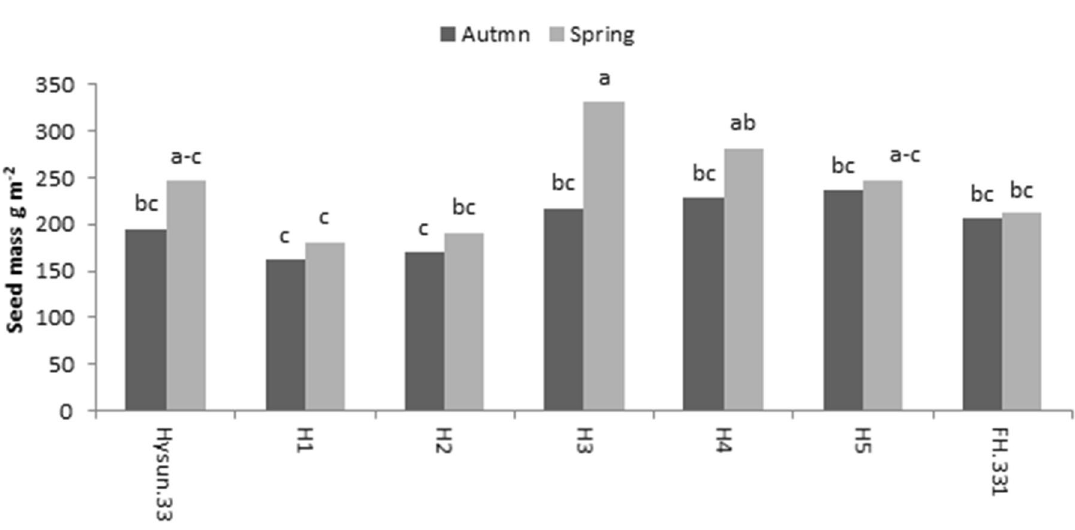
Figure 6. Seed mass (g m −1 ) of sunflower hybrids varied for drought and heat tolerance averaged over locations within spring and autumn